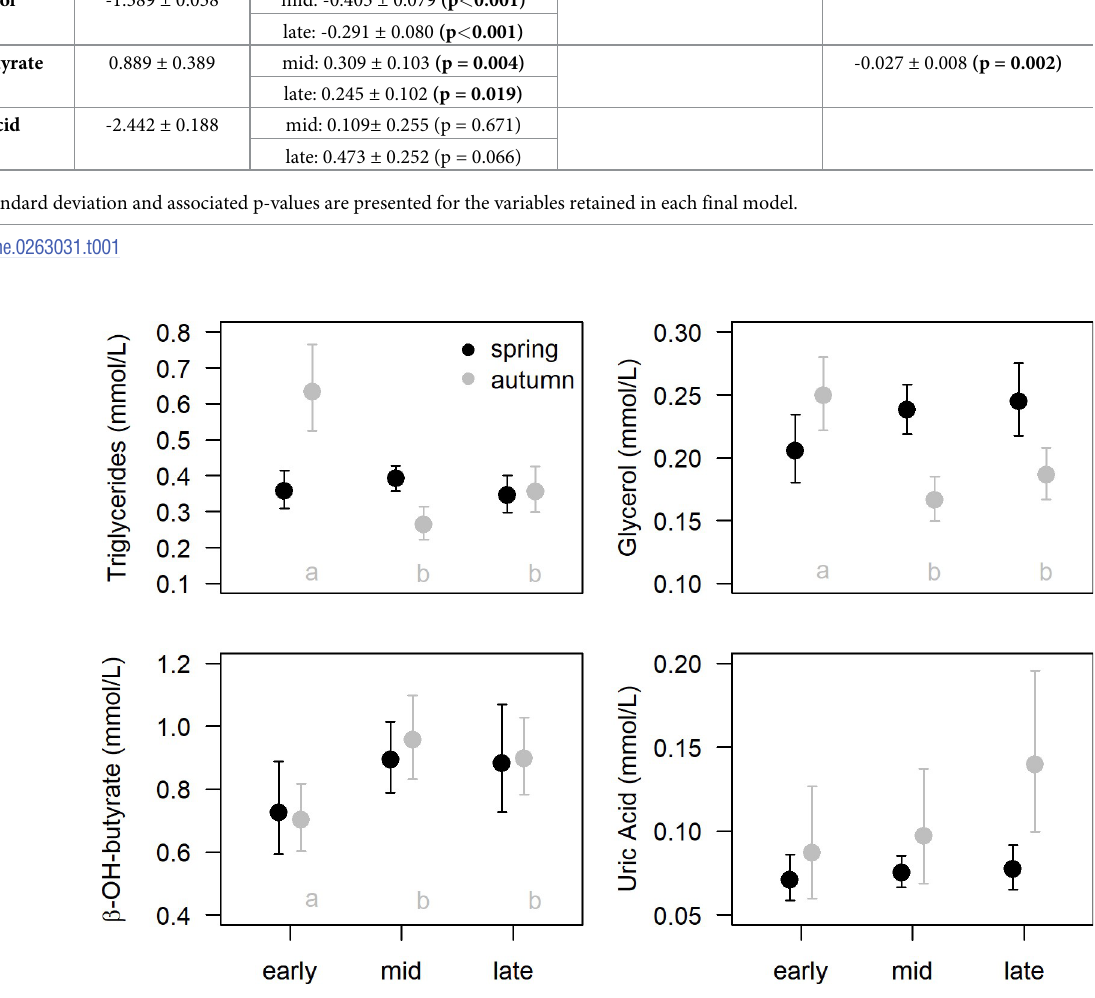
Fig 1. Plasma metabolite concentrations of dunlins sampled at the Tagus estuary at different migratory stages (early, mid and late) during spring and autumn migrations. Data (mean ± confidence intervals of the mean) are predictions from the selected models (see Table 1) where significant covariates were set with the same mean value in all groups. Different letters indicate significant differences between stages within the same migration (see Results). N = 13, 33 and 16 for early, mid and late stages, respectively, in spring migration; N = 16, 19 and 18 (20 for β -hydroxybutyrate and uric acid) for early, mid and late stages, respectively, in autumn